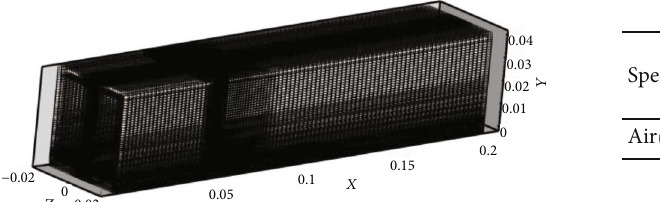
Table 5: Water injection conditions.